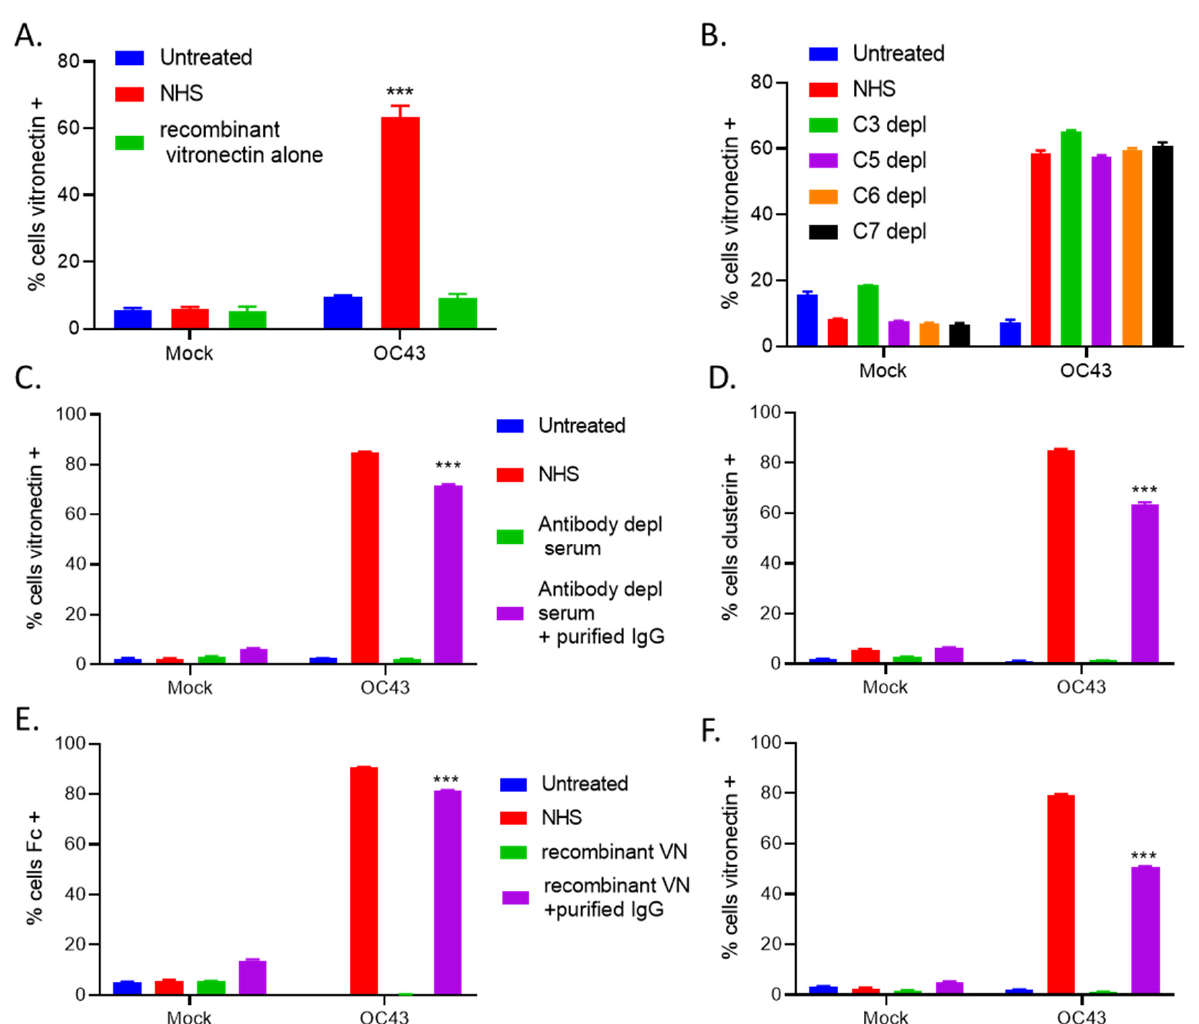
Figure 8. VN was bound to OC43 infected lung cells independently of key C’ pathway components and VN and CLU recruitment required antibodies from NHS. ( A ) Uninfected (mock) or OC43 infected H1299 cells were either untreated or treated with NHS or physiological levels of recombinant VN for 1 h at 37 ◦ C. Cells were washed and probed for VN surface staining. Values are the mean of three replicates and error bars representing standard deviation, with *** indicating p -value of < 0.001 comparing NHS treated versus recombinant VN alone treated infected samples. ( B ) Uninfected (mock) or OC43 infected cells were left untreated or treated with 10% NHS, or 10% C3, C5, C6, or C7 depleted (depl) serum for 1 h at 37 ◦ C. Cells were washed and probed for VN ( B ) surface staining. ( C , D ) Uninfected (mock) or OC43 infected cells were untreated or treated with 10% NHS, or 10% antibody depl serum, or 10% antibody depl serum plus physiological levels of purified IgG antibodies from human serum for 1 h at 37 ◦ C. Cells were washed and probed for VN ( C ), or CLU ( D ) surface staining. *** indicated p -value of <0.001 comparing antibody depl serum treated infected samples versus antibody depl serum plus purified IgG treated infected samples. ( E , F ) Uninfected (mock) or OC43 infected cells were untreated or treated with 10% NHS, or treated with recombinant VN alone, or recombinant VN plus purified IgG antibodies from human serum for 1 h at 37 ◦ C. All treatments were performed using physiological serum levels of recombinant VN (200 µ g/mL) and purified IgG (7 mg/mL). Cells were washed and probed for antibody Fc ( E ), or VN surface staining ( F ). Values in all panels are the mean of three replicates and error bars representing standard deviation, *** indicating p -value of <0.001 comparing recombinant VN treated infected cells versus recombinant VN plus purified IgG treated infected samples. Mock denotes uninfected control